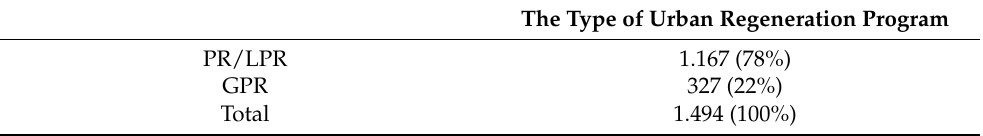
Table 1. Two types of urban regeneration programs in Poland (PR/LPR and GPR).